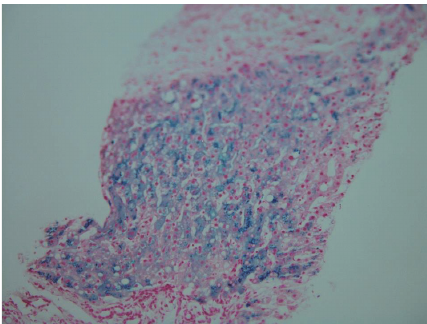
Figure 1: Liver biopsy demonstrating increased iron content in hepatocytes and Kupffer